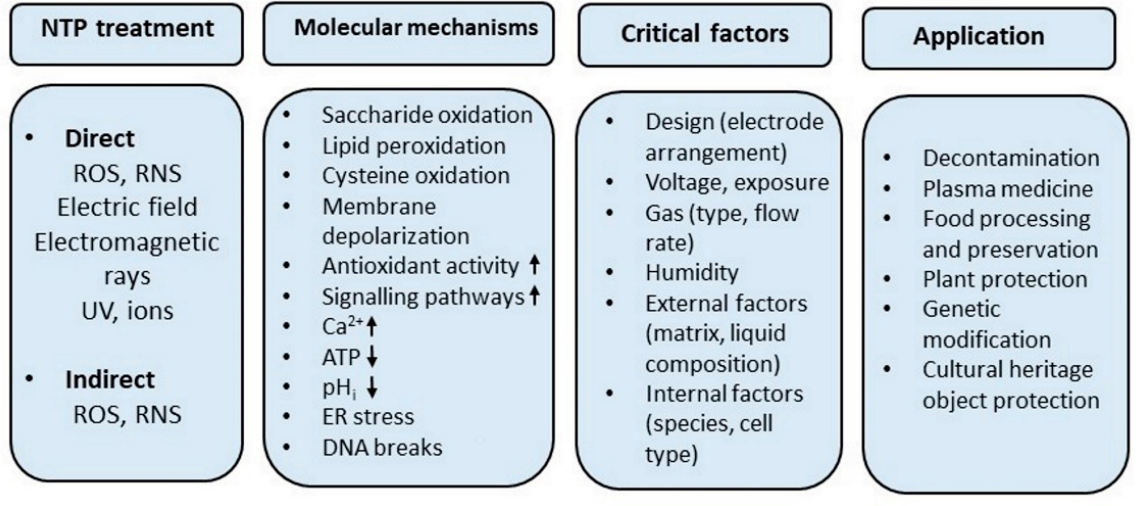
Figure 2. NTP and fungi: treatment setups, applications, and fungal response.